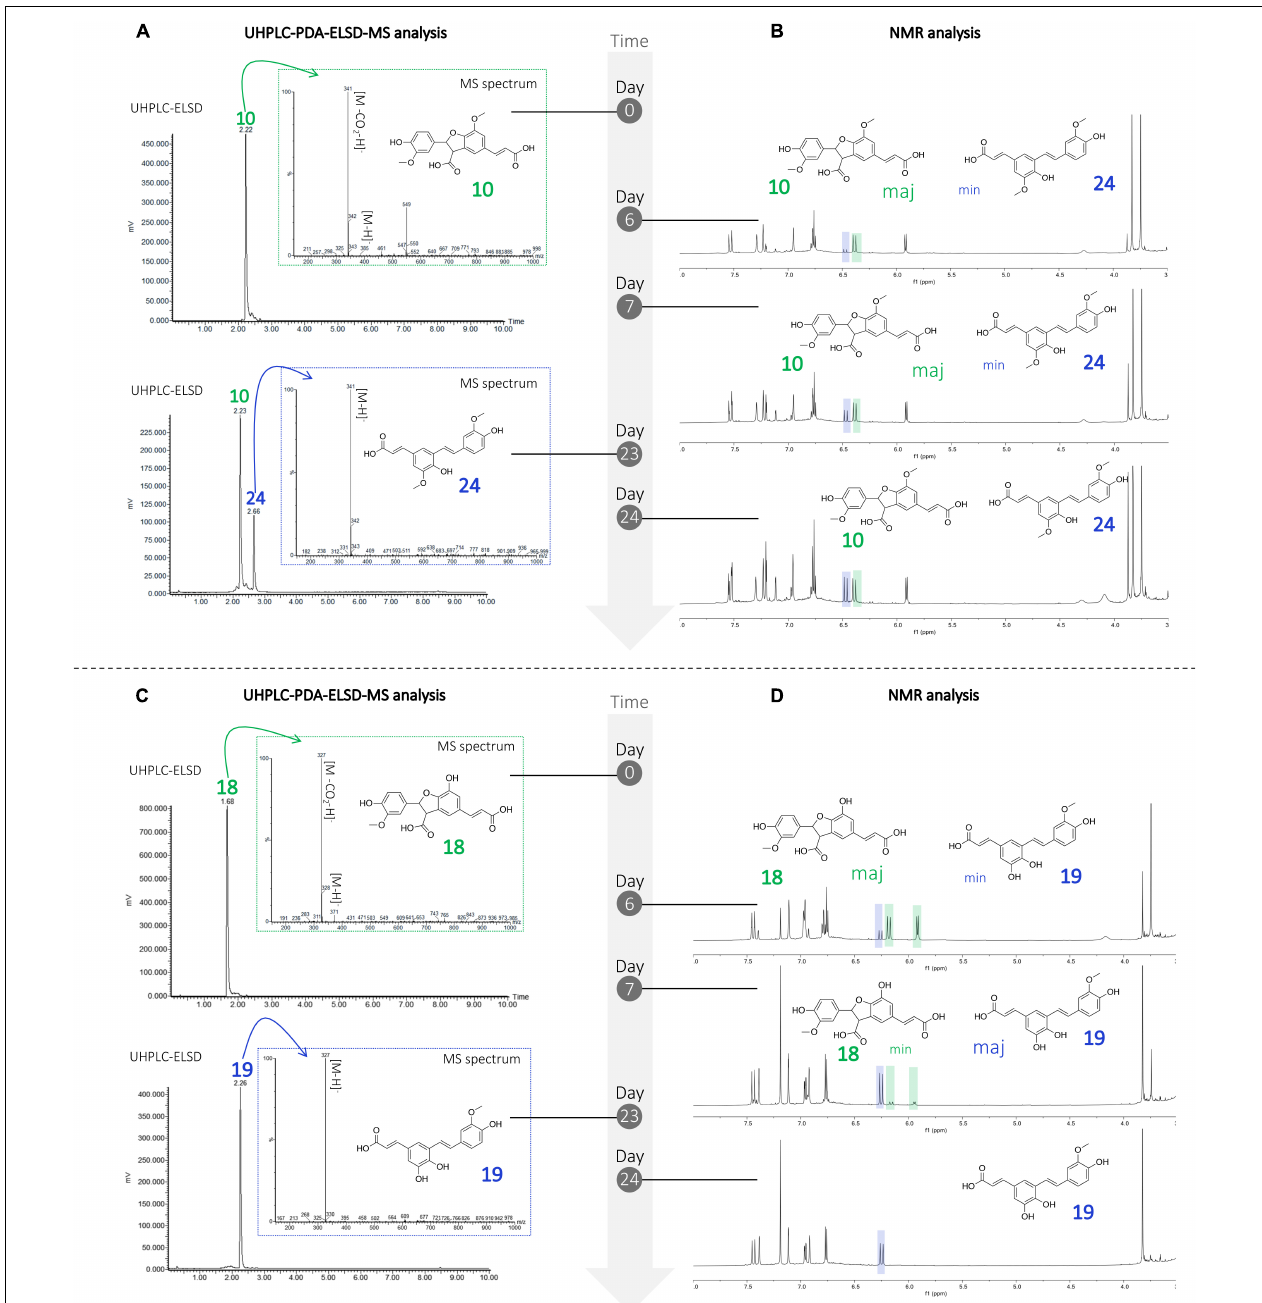
FIGURE 6 | Monitoring of the degradation of the compounds undergoing decarboxylation (A) UHPLC-PDA-ELSD-MS and (B) NMR analysis showing the degradation of compound 10 in 24, (C) UHPLC-PDA-ELSD-MS and (D) NMR analysis showing the degradation of compound 18 in 19.